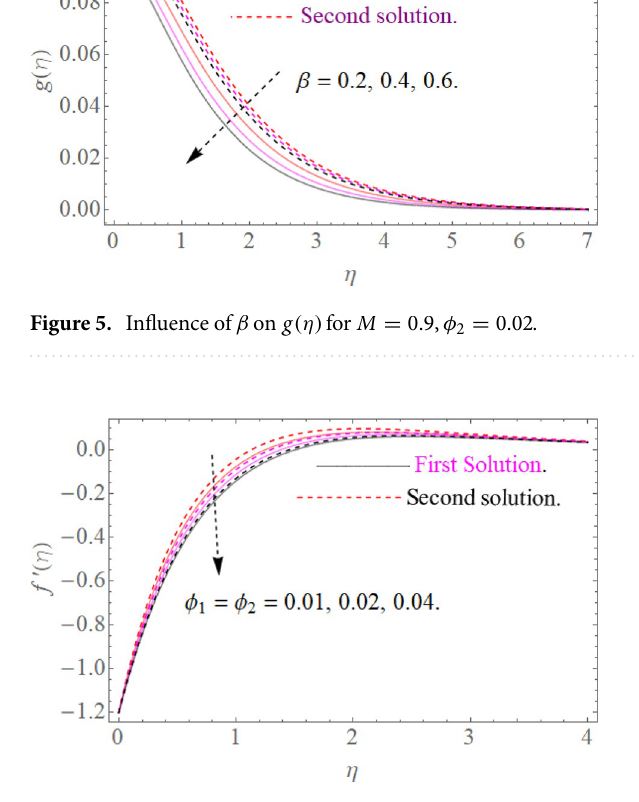
Figure 6. Influence of φ 2 on f ′ (η) for M = 0.9, β = 0.2 .